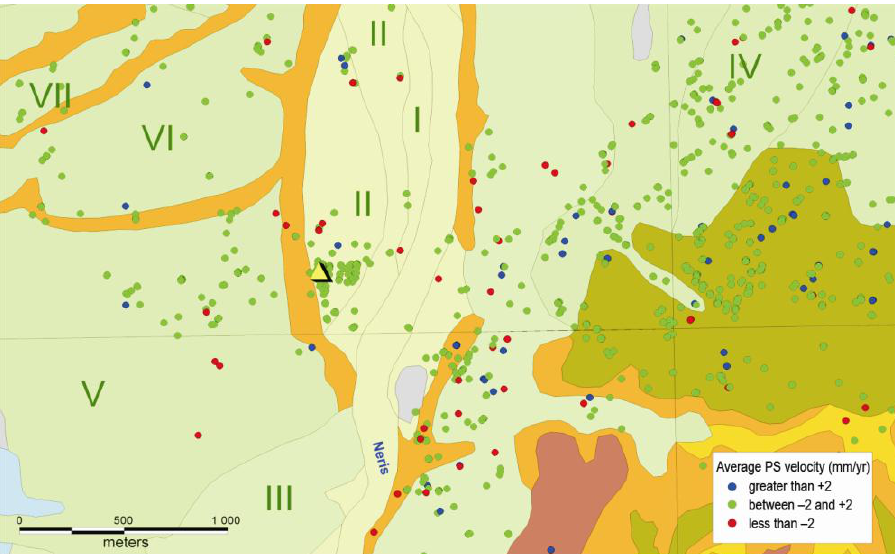
Fig. 3. PS with negative velocities below – 2 mm/yr (red dots), PS with velocities exceeding +2 mm/yr (blue), stable points between – 2 mm/yr and +2 mm/yr (green) and reference point (yellow triangle) superimposed on the background of geological map at the scale 1: 50000 (Gu- obytė 1996). Numbers I, II and III indicate alluvial terraces of Neris River, brown colour shows delluvial